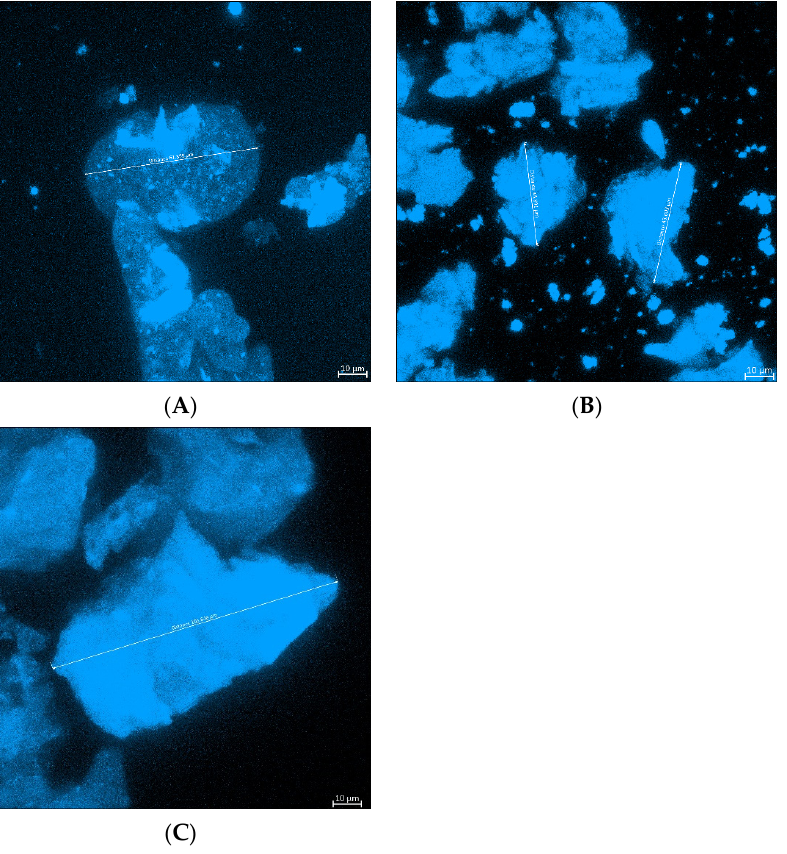
Figure 1. Confocal laser scanning microscope images of the three microparticle formulations, namely: ( A ) E + AVP emulsion, ( B ) AVP emulsion, and ( C ) AVP ionic gelation.